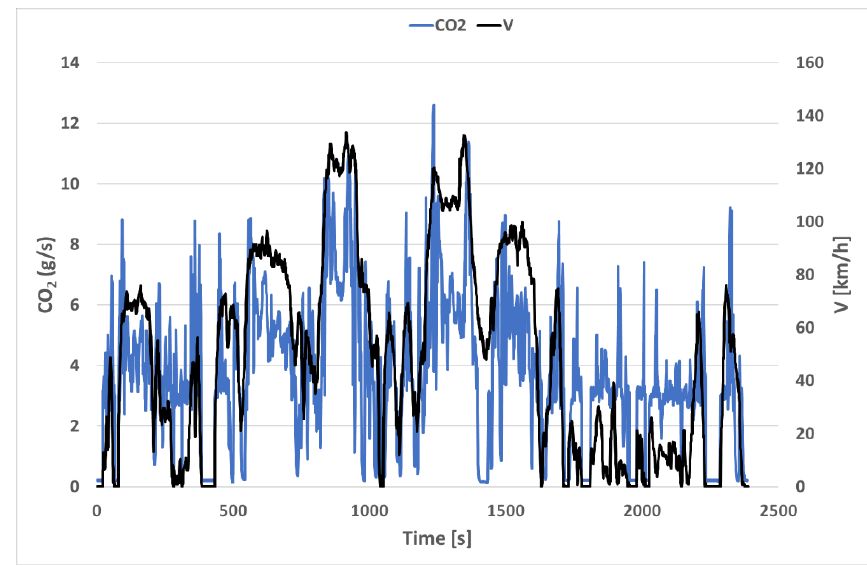
Figure 11. CO 2 emission versus vehicle speed in on-road test, petrol propulsion.